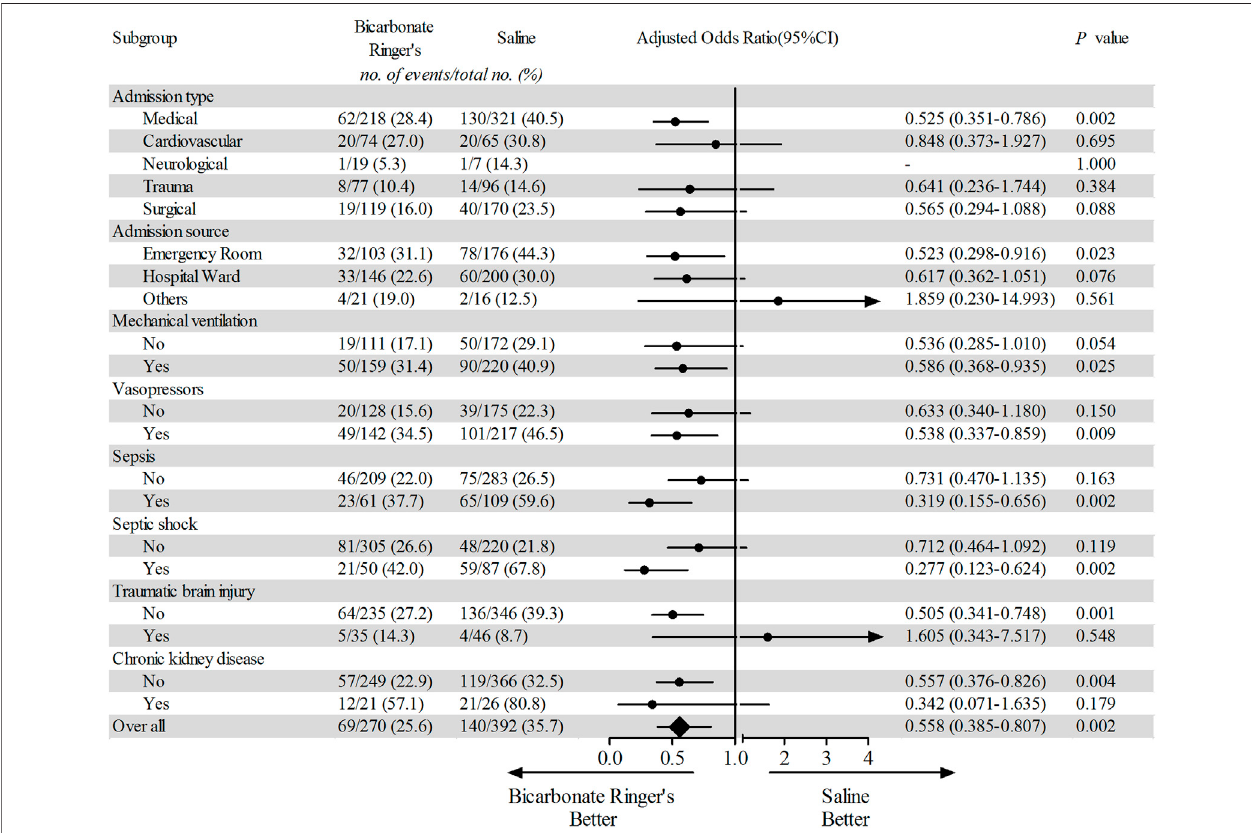
Frontiers in Pharmacology |